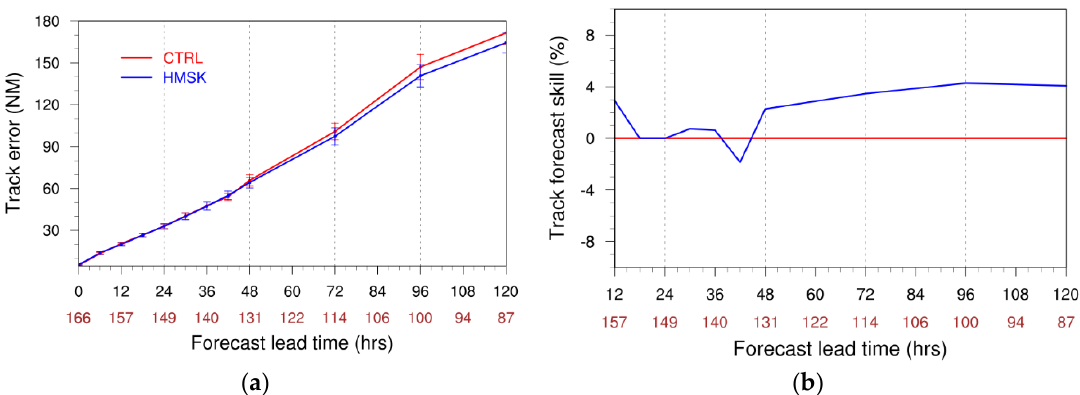
Figure 8. Performance comparison of track forecasts between CTRL (the first experiment, red) and HMSK (the second experiment, blue) from the four selected Atlantic hurricanes in 2017–2018. The number of cases for each lead time is provided at the bottom of each column. ( a ) Verification of track forecast errors from experiments with/without high-resolution land–sea mask. Absolute average error (lines) and standard deviation (vertical bars) are a function of forecast time and number of cases. The error bar represents the 95% confidence interval. ( b ) Track improvements (vs. CTRL) are shown for hurricane forecasts from HMSK.